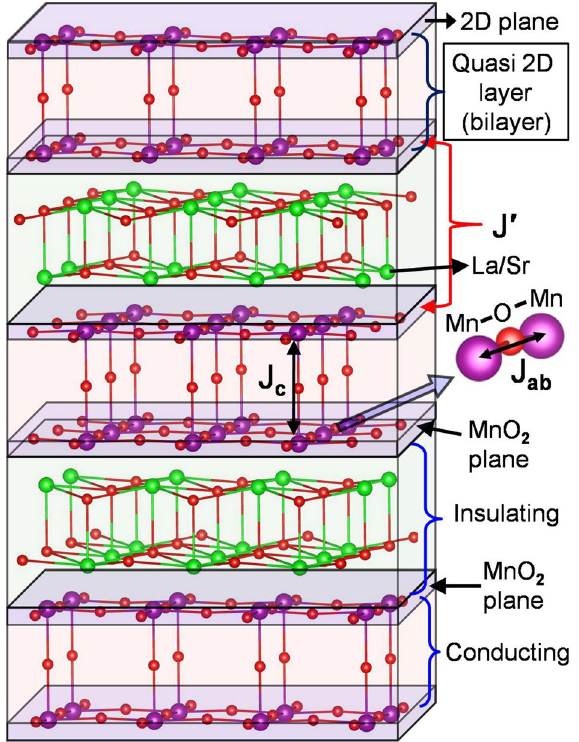
Figure 1. Schematic diagram of stacked bilayer La 2 − 2 x Sr 1 + 2 x Mn 2 O 7 : two consecutive bilayers are separated by insulating layer. The parameters J ′ , J c and J ab are magnetic interaction strength between Mn ions in MnO 2 planes separated by an insulating layer, Mn ions of different MnO 2 planes in the bilayer and Mn ions in a MnO 2 plane,